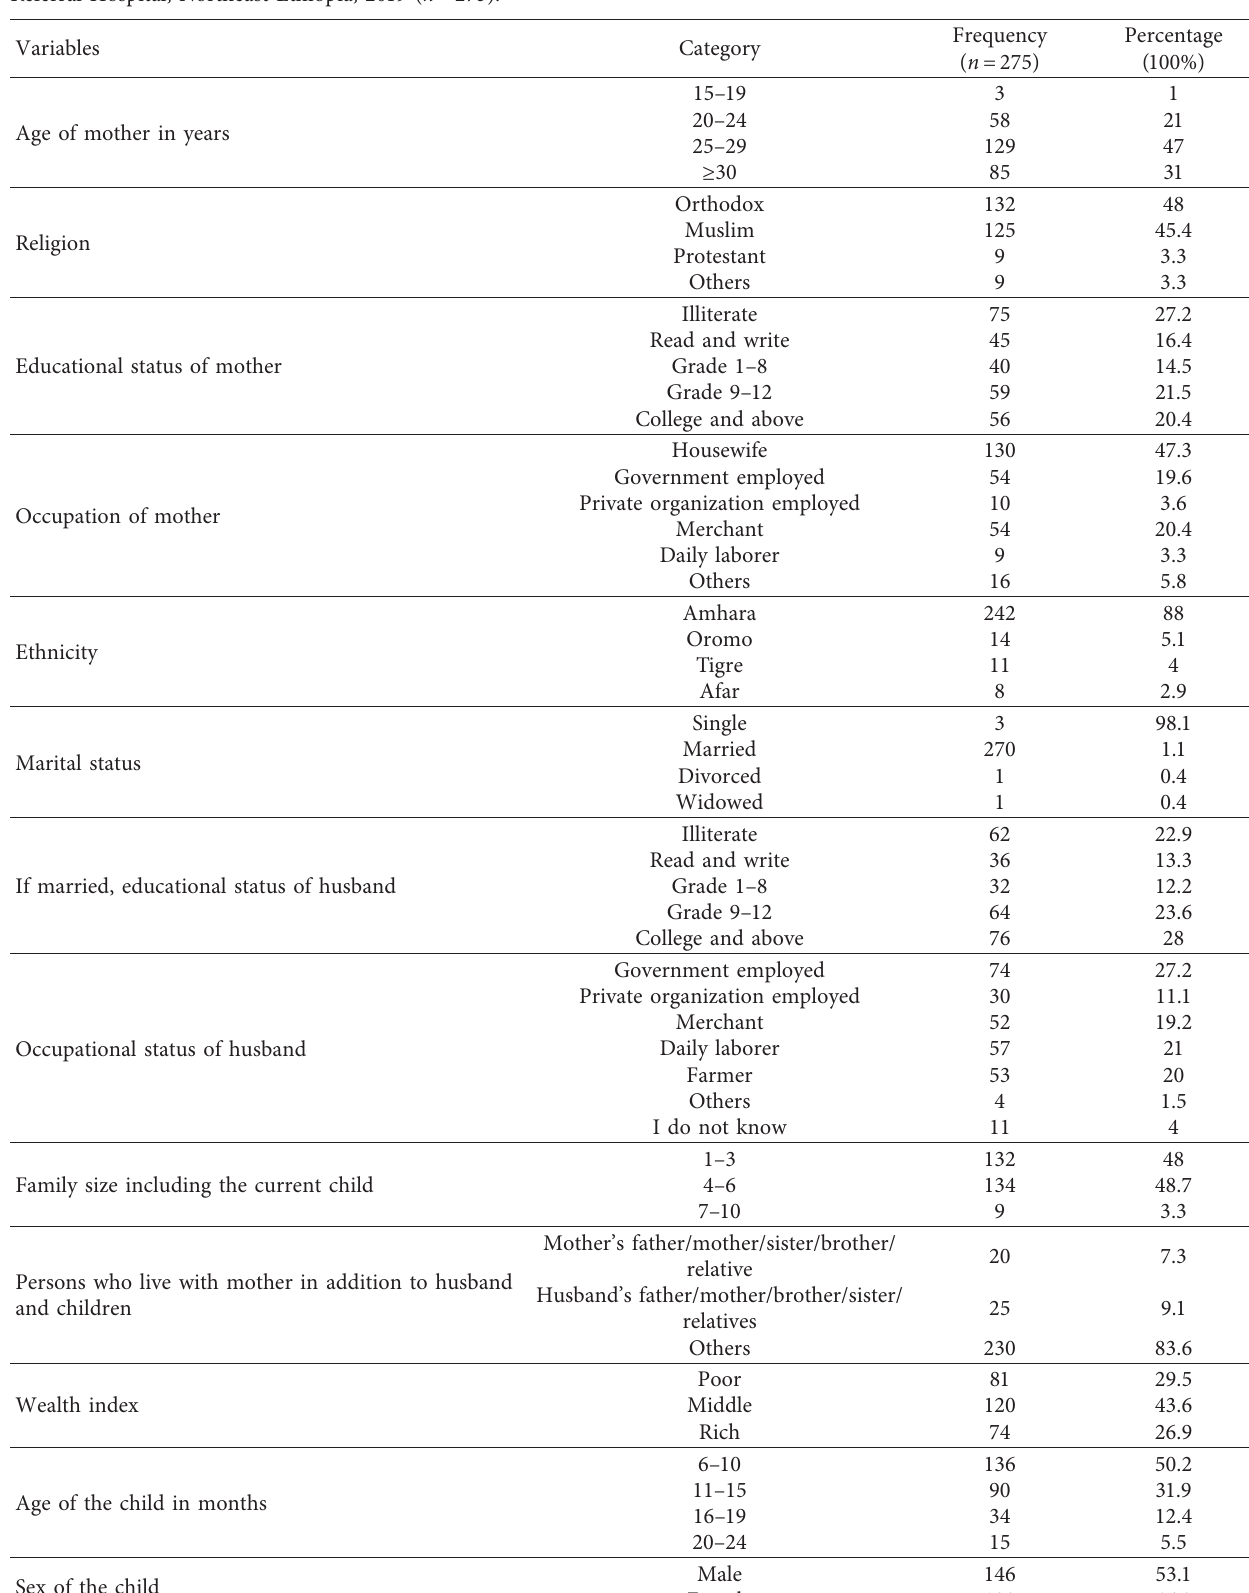
Table 1: Frequency and percentage distribution of sociodemographic characteristics of mother with children aged 6–24 months in Dessie Referral Hospital, Northeast Ethiopia, 2019 ( n �